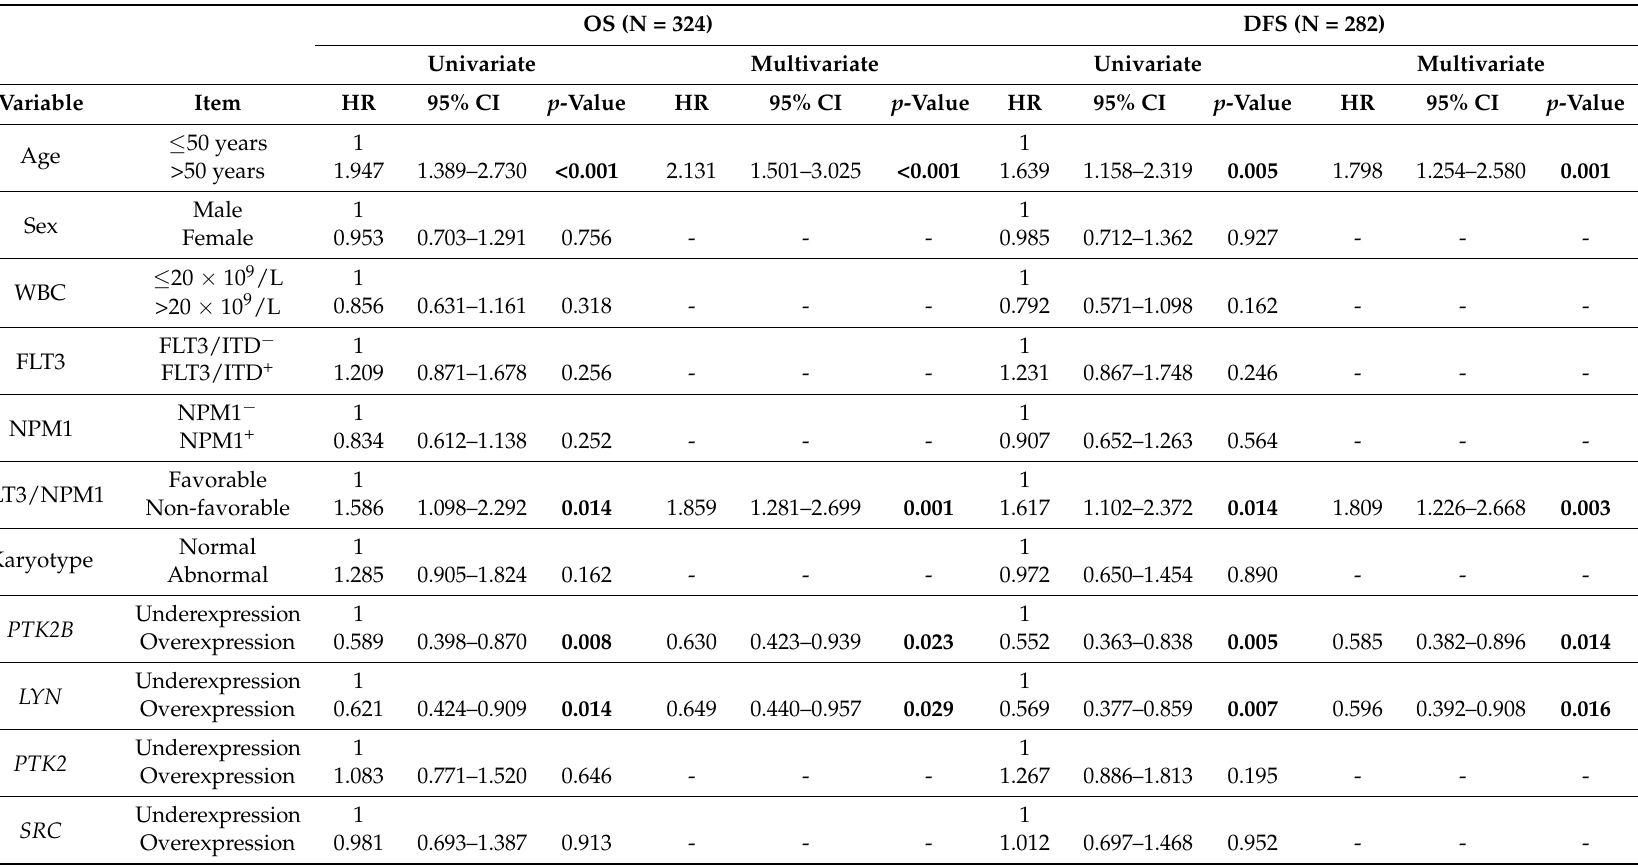
Table 1. Univariate and multivariate analyses of the association between relevant clinical variables and focal adhesion gene expression with overall survival (OS) or disease-free survival (DFS) in the cytogenetic IR-AML